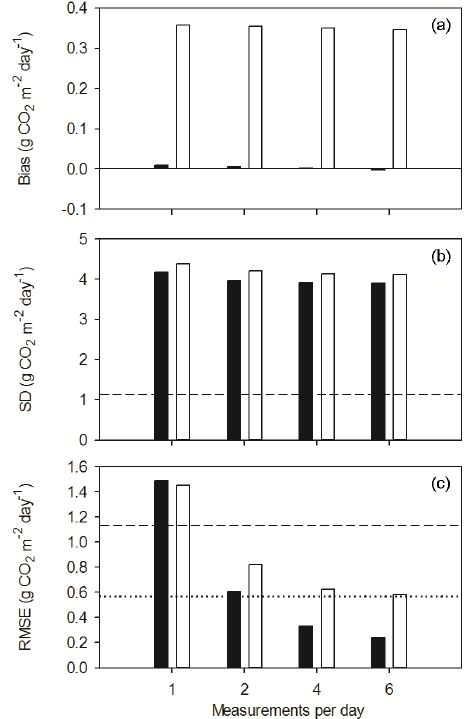
Figure 5. Statistics of the estimation of daily R s flux from partial- data series, considering day and night measurements (dark bars) and only daytime measurements (light bars) ( n = 10000). Sta- tistical parameters are bias (a) , standard deviation (b) and root mean square error (RMSE) (c) . The reference lines in (b, c) rep- resent 10% (dashed) and 5% (dotted) of the mean daily R s flux (11.38gCO 2 m − 2 day − 1 )